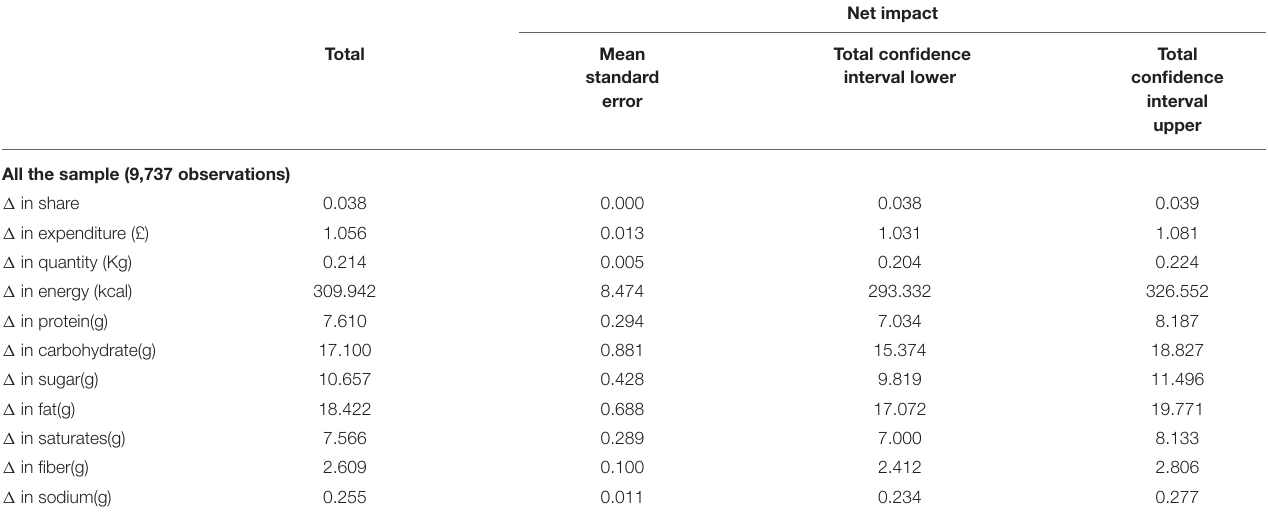
TABLE 6 | Net results of the simulation on other non-discretionary food and drinks (Changes are in per capita per week terms).